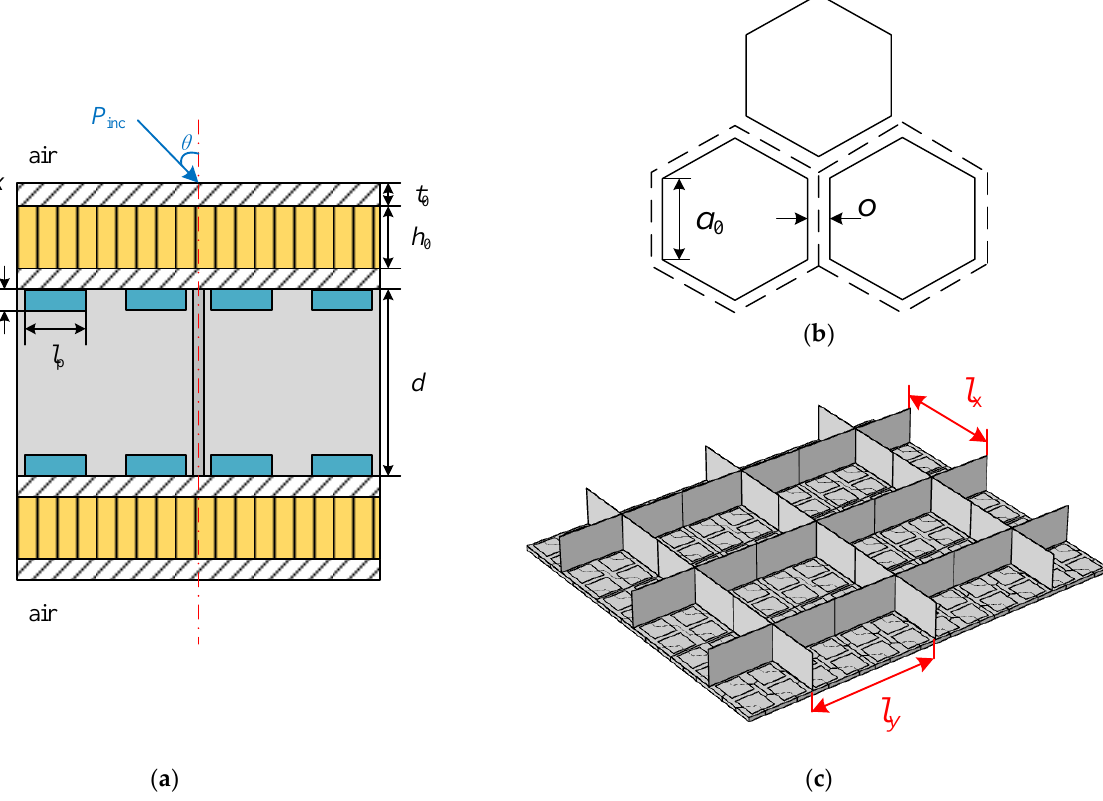
Figure 1. Schematic diagram of an orthogonally rib-stiffened honeycomb double sandwich structure with periodic arrays of shunted piezoelectric patches: ( a ) Side view of a periodic element of the research structure; ( b ) Honeycomb structure; ( c ) Orthogonal rib-stiffeners.